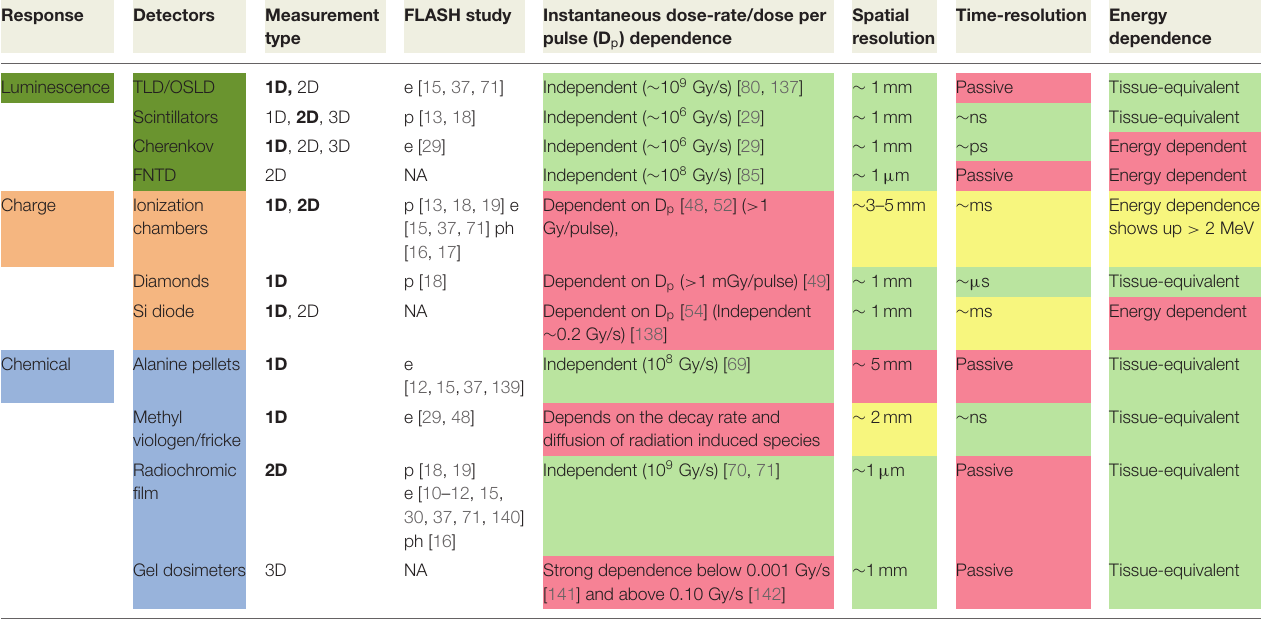
TABLE 1 | Dosimeters and their capabilities rated for potential FLASH dose measurement of key parameters. Response